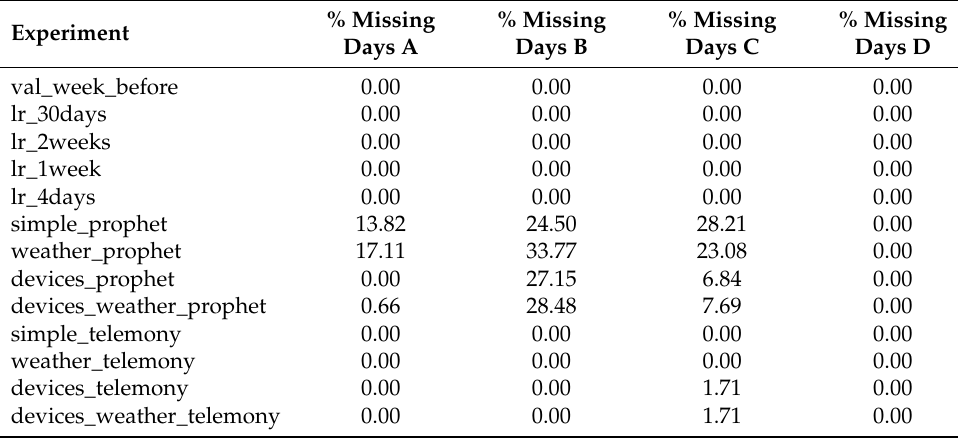
Table 4. The percent of forecasts that could not be obtained from the